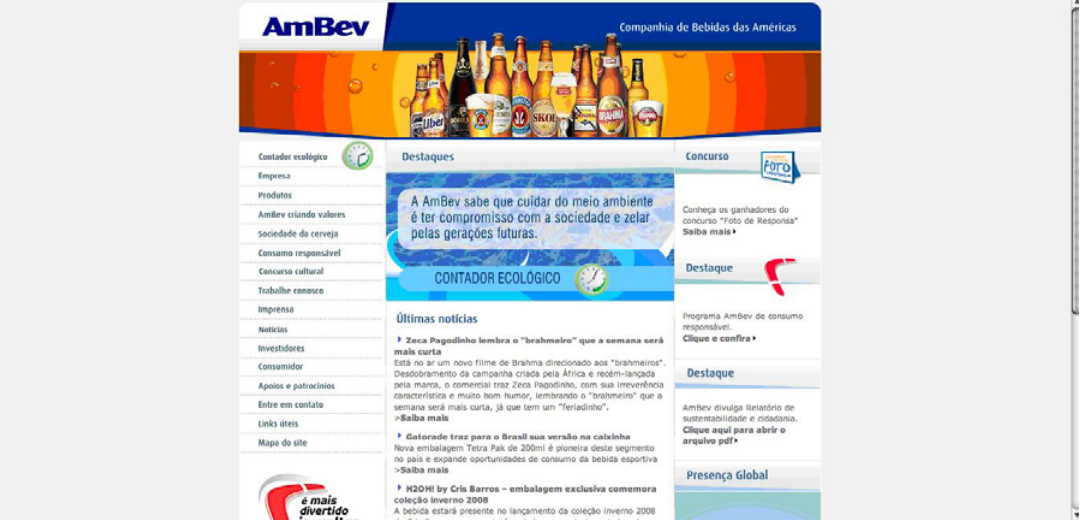
Figure 2. Screenshot of Ambev Brazil main webpage